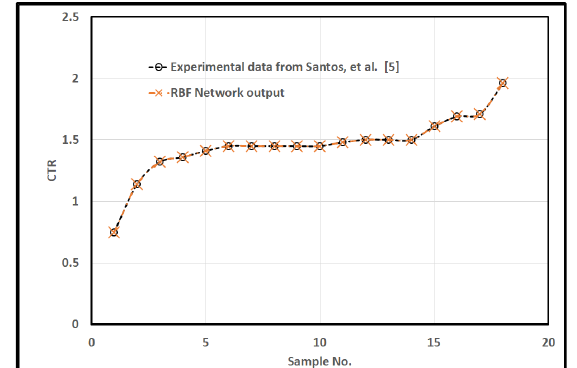
Fig. 6. The neural network for the experimental data from Santos, et al. [5] .